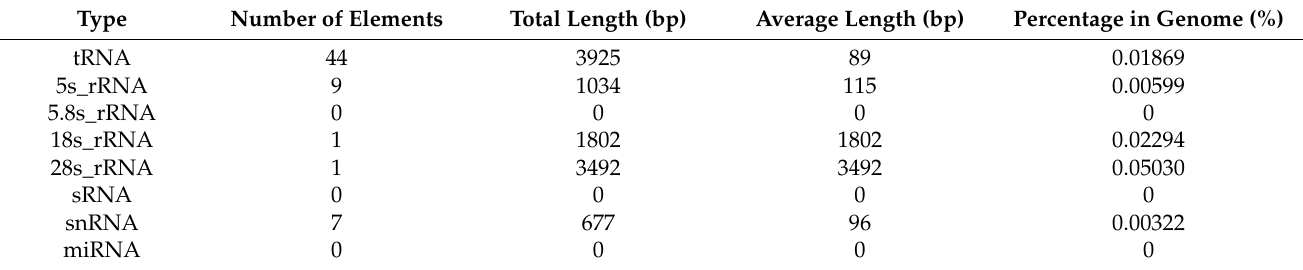
Table 4. Statistical results of noncoding RNAs in the N. aurantialba NX-20